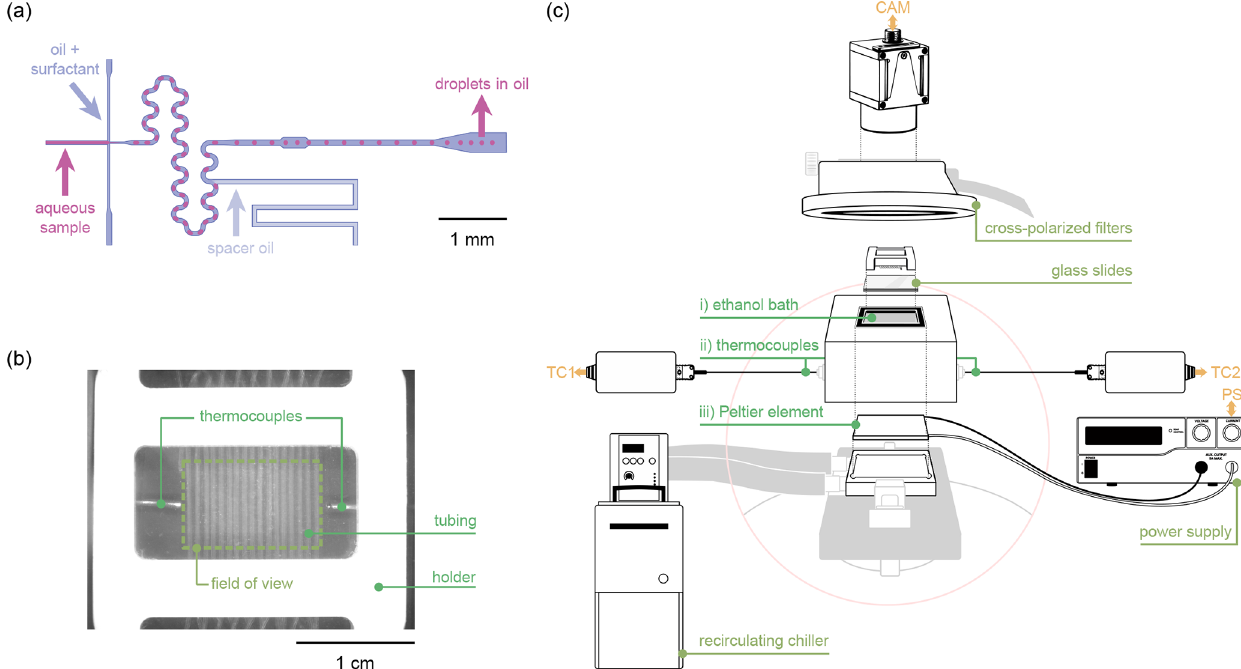
Figure 1. Overview of the Microfluidic Ice Nuclei Counter Zürich (MINCZ): (a) microfluidic channels used to generate aqueous droplets surrounded by an oil–surfactant continuous phase; (b) a top-down image of the ethanol bath into which the PEEK holder with PFA tubing is placed, with the dashed outline showing the field of view visible to the camera; (c) the equipment used for cooling the ethanol bath (i) in which the tubing is placed. Temperature is measured by two thermocouples (ii), and temperature control is achieved with a Peltier element